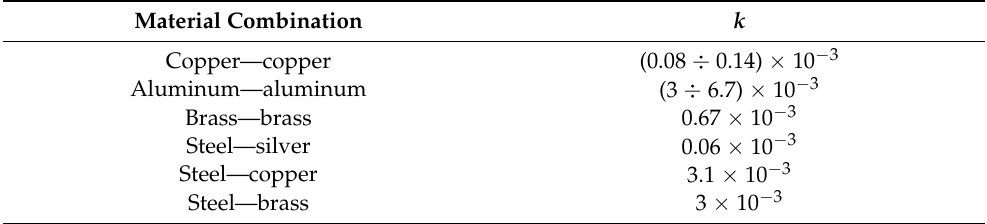
Table 1. Table of material dependent proportionality factor k [19].